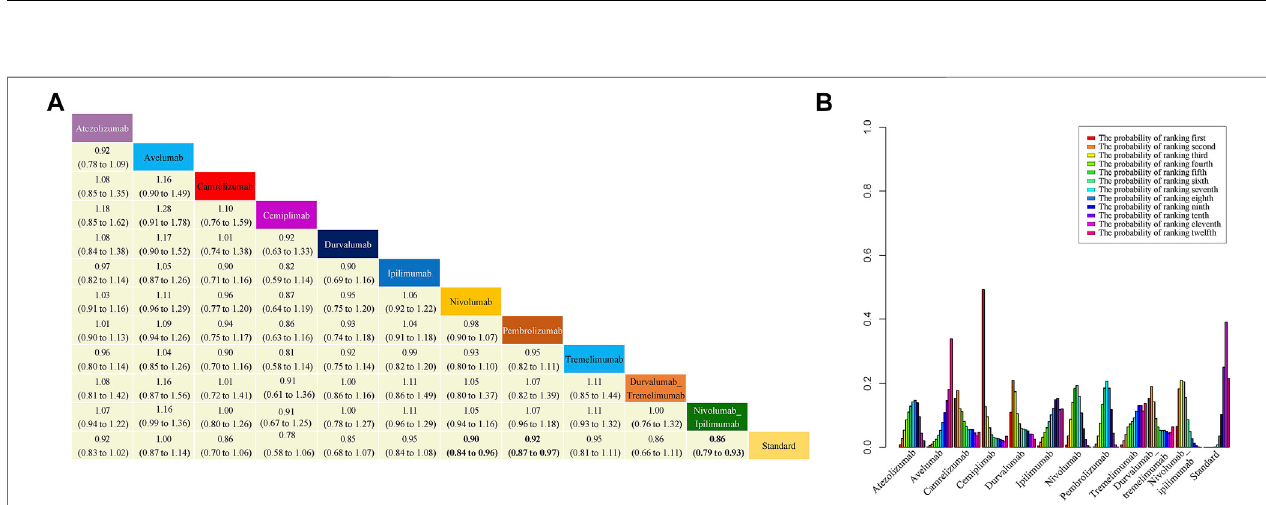
FIGURE 3 | Results of network meta-analysis (NMA), safety pro fi le (A) and probability ranking diagram (B) in the Bayesian model. In the safety pro fi le, ef fi cacy of treatment for progression-free survival (PFS) is represented as hazard ratios (HRs) with 95% con fi dence intervals. All comparisons are made as column versus row. Statistically signi fi cant results are in bold. Probability ranking diagram shows the probability of the safety of different therapies ranking the fi rst to the last for PFS.